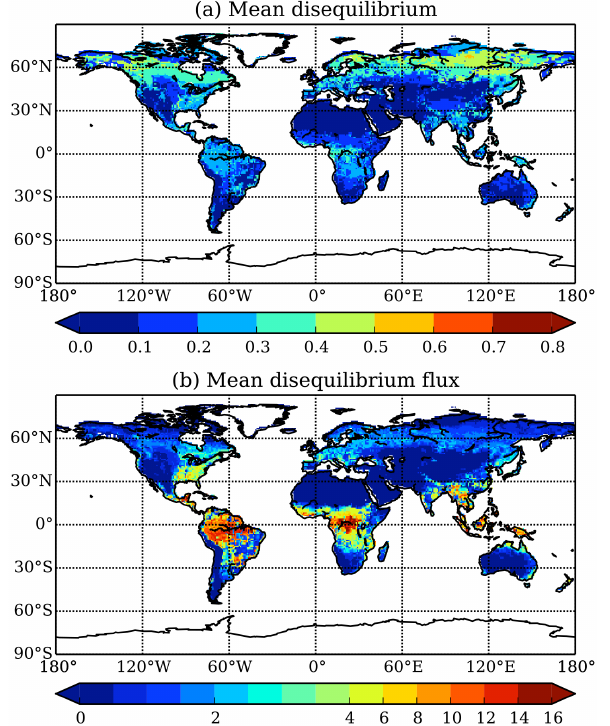
Figure 5. The (a) SiBCASA-ISOVAR disequilibrium coefficient (‰) and (b) disequilibrium flux (TgC‰cell − 1 yr − 1 ), averaged for a 12yr period (1997–2008). Note that the color scale in panel (b) is nonlinear.